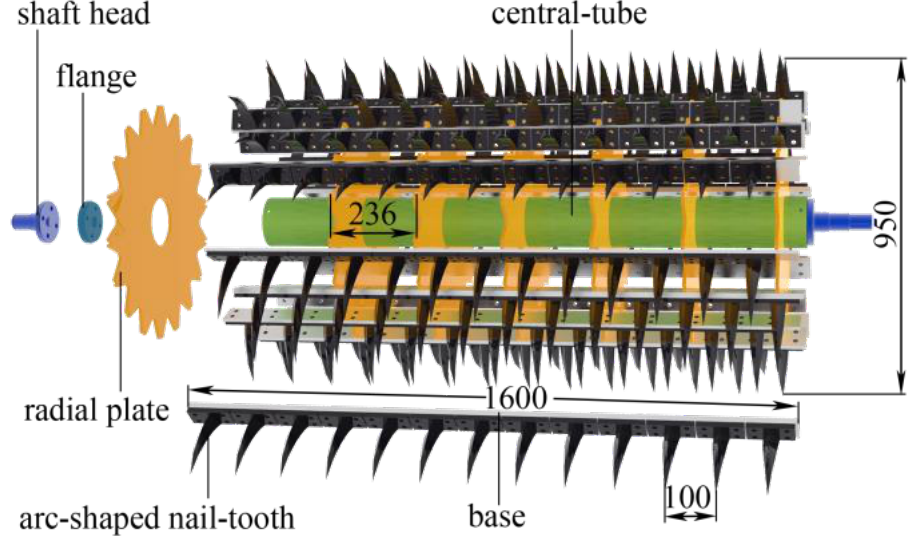
Figure 2. Structure diagram of the tooth roller device.